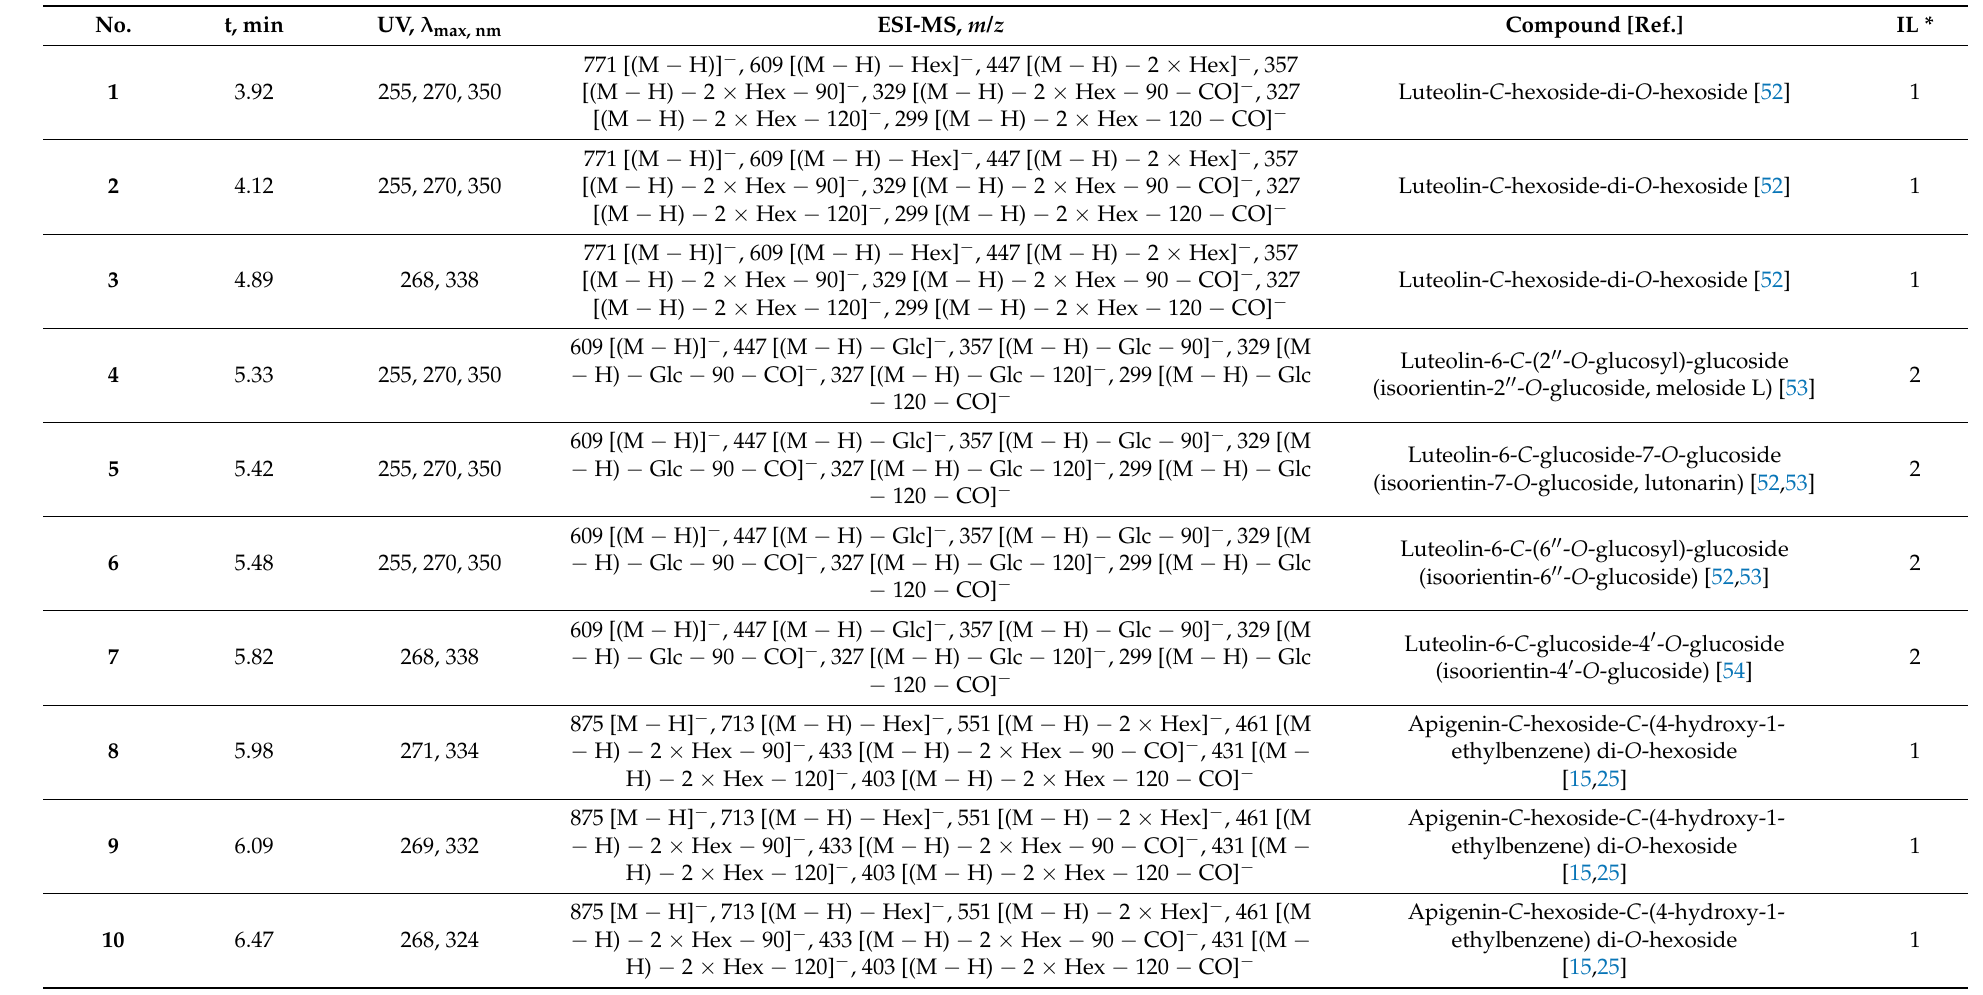
Table 6. Chromatographic (t) and ultraviolet (UV) and mass-spectrometric (ESI-MS) data of compounds 1 – 47 found in Amberlite XAD-2 fraction of cucumber